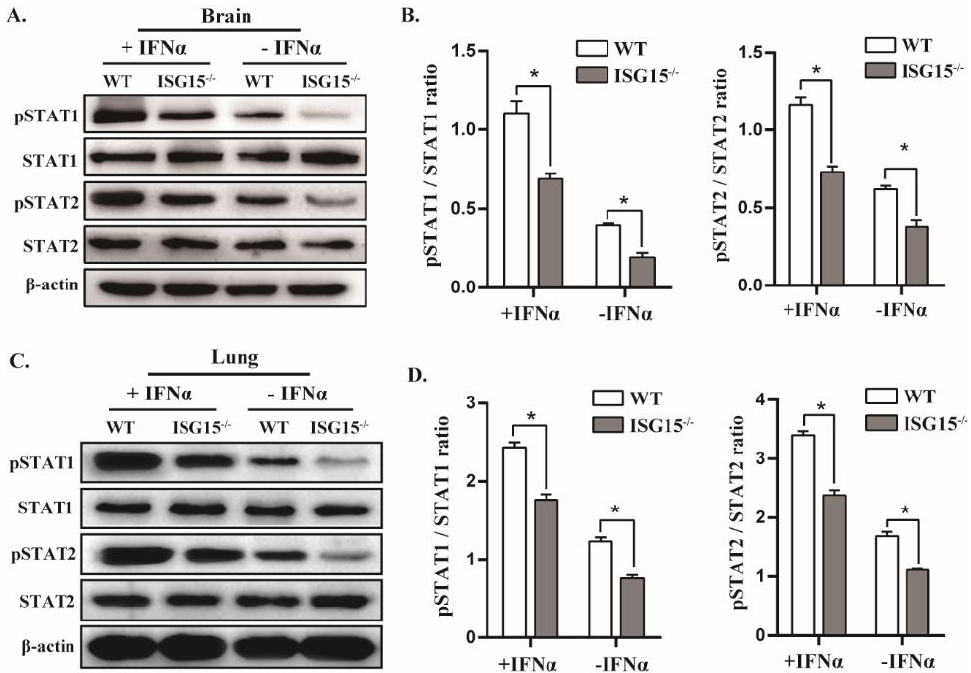
Figure 6. STAT1 and STAT2 phosphorylation are considerably reduced in infected ISG15 -/- mice. The tissues of infected WT and ISG15 -/- mice either pretreated or left untreated were harvested and analyzed by Western blotting with the indicated antibodies ( A , C ). Phosphorylated STAT1 or STAT2 levels relative to STAT1 or STAT2 were quantitated by densitometry and normalized to β -actin ( B , D ). The average of three independent replicates were plotted (means ± SD). * p < 0.05.